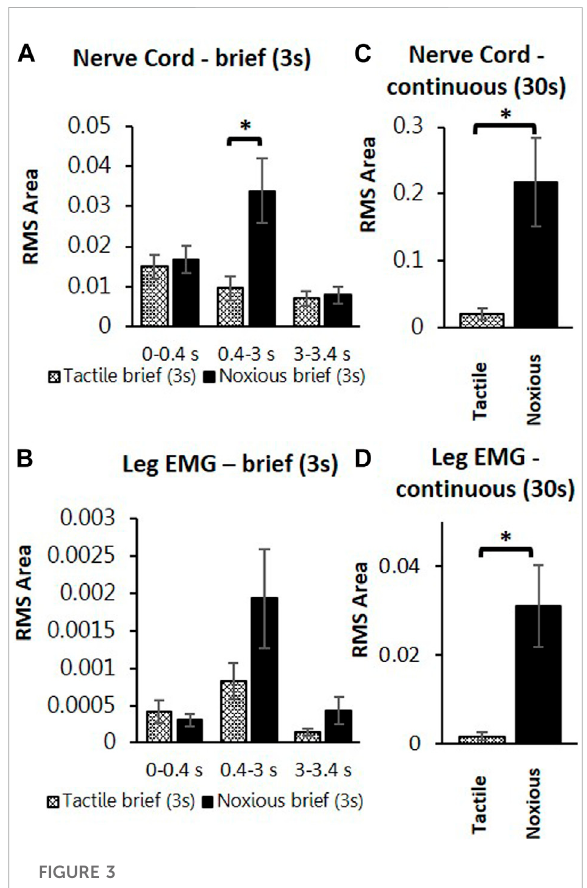
Continuous noxious stimulus evokes robust response in interneurons and motoneurons compared with tactile stimulus in stung cockroaches. (A) Averaged RMS area of the nerve cord response to brief tactile (White bar with cross) and noxious stimuli (Black bar), according to the time divisions as represented withgreylinesinFigure2A.Panel (B) isthesameaspanel (A) forthe leg EMG response. (C) Averaged RMS area of nerve cord response to a continuous transition between tactile (White bar with cross) and noxious (Black bar) stimuli. Panel (D) is the same as panel (C) for the leg EMG response. Bars represent means ± SEM, signi fi cance is indicated with an